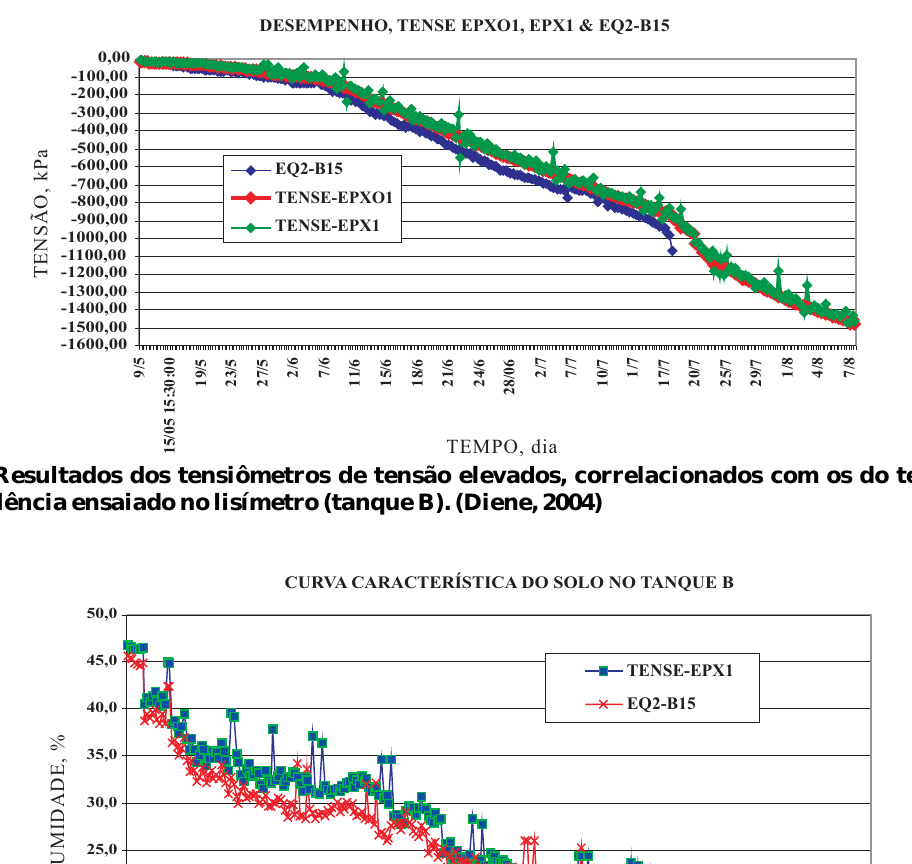
DESEMPENHO, TENSE EPXO1, EPX1 & EQ2-B15